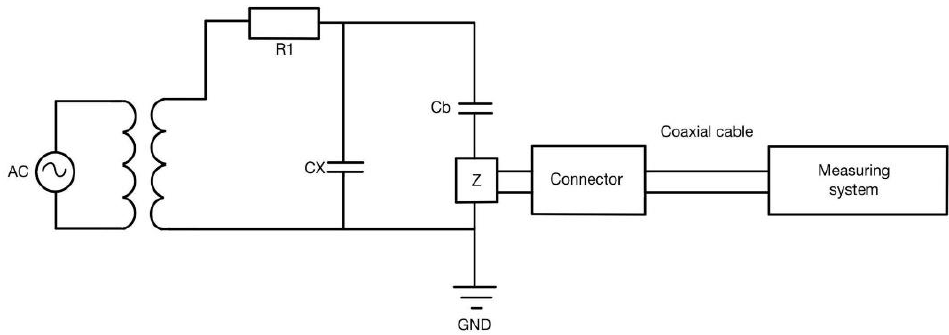
Figure 11. Test circuit for partial discharges [110].